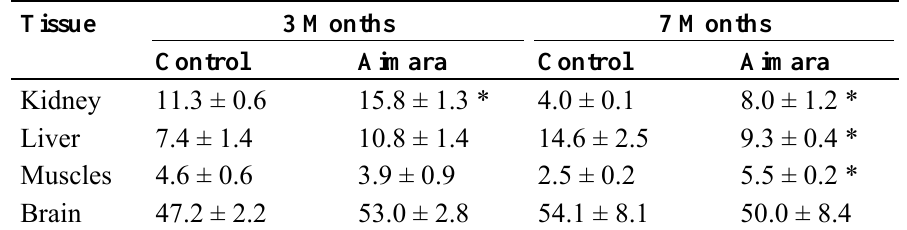
Table 7. Metallothionein concentrations in tissues from mice fed aimara-containing diet for 7 months a